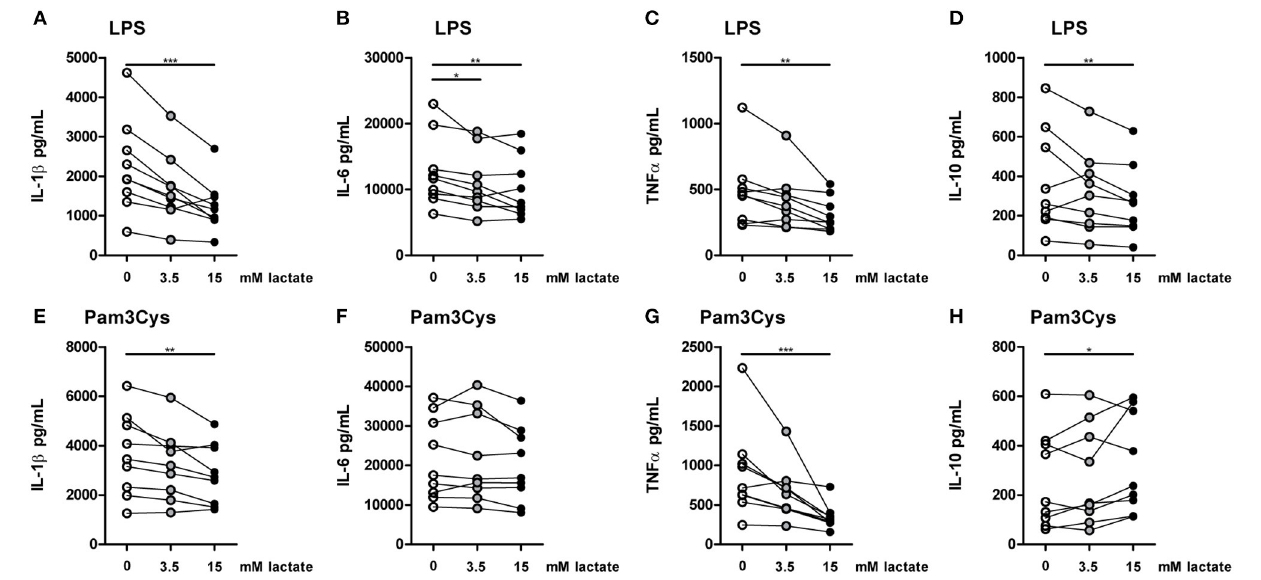
FIGURE 7 | In vitro , lactate has anti-inflammatory effects on PBMCs. Cytokine production of PBMCs from healthy individuals (4 men, 5 women). PBMCs were pretreated with lactate for 1h before LPS (A–D) or Pam3Cys (E–H) was added for 24h. (A–H) n = 9. * p < 0.05, ** p < 0.01, *** p < 0.001, Friedman test with post-hoc Dunn’s